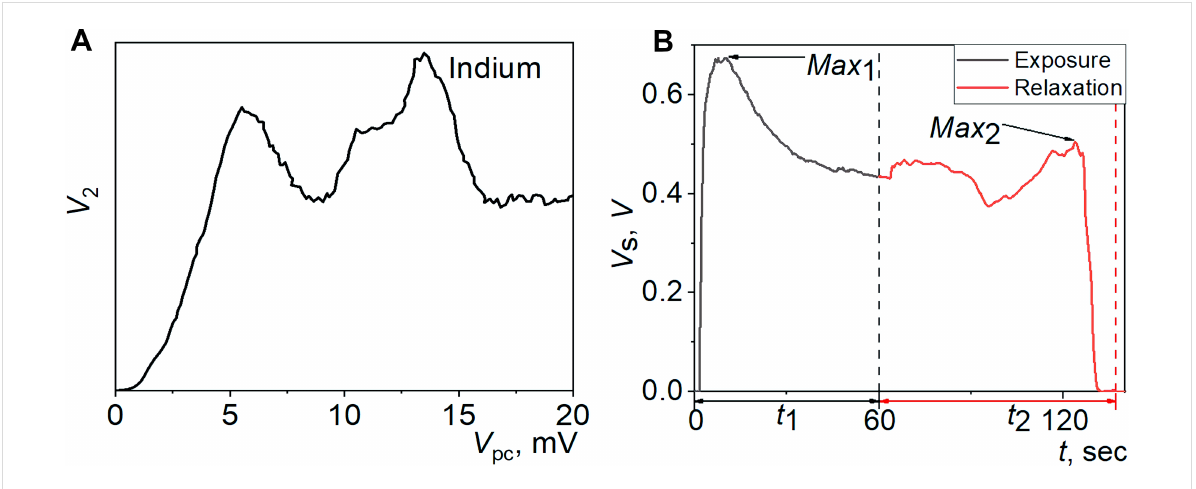
Figure 1: (a) Spectrum of the electron–phonon interaction in indium obtained using Yanson point contacts. V 2 is the second derivative of the current–voltage characteristic of the point contact and V pc is the decrease in contact voltage. (b) A typical time dependence of the point-contact sensor conductance based on TCNQ compounds as a result of its interaction with the human breath (i.e., the breath point-contact sensor profile). V s is the voltage decrease that occurs in the sensor, t is the time, t 1 is the exposure time, and t 2 is the relaxation